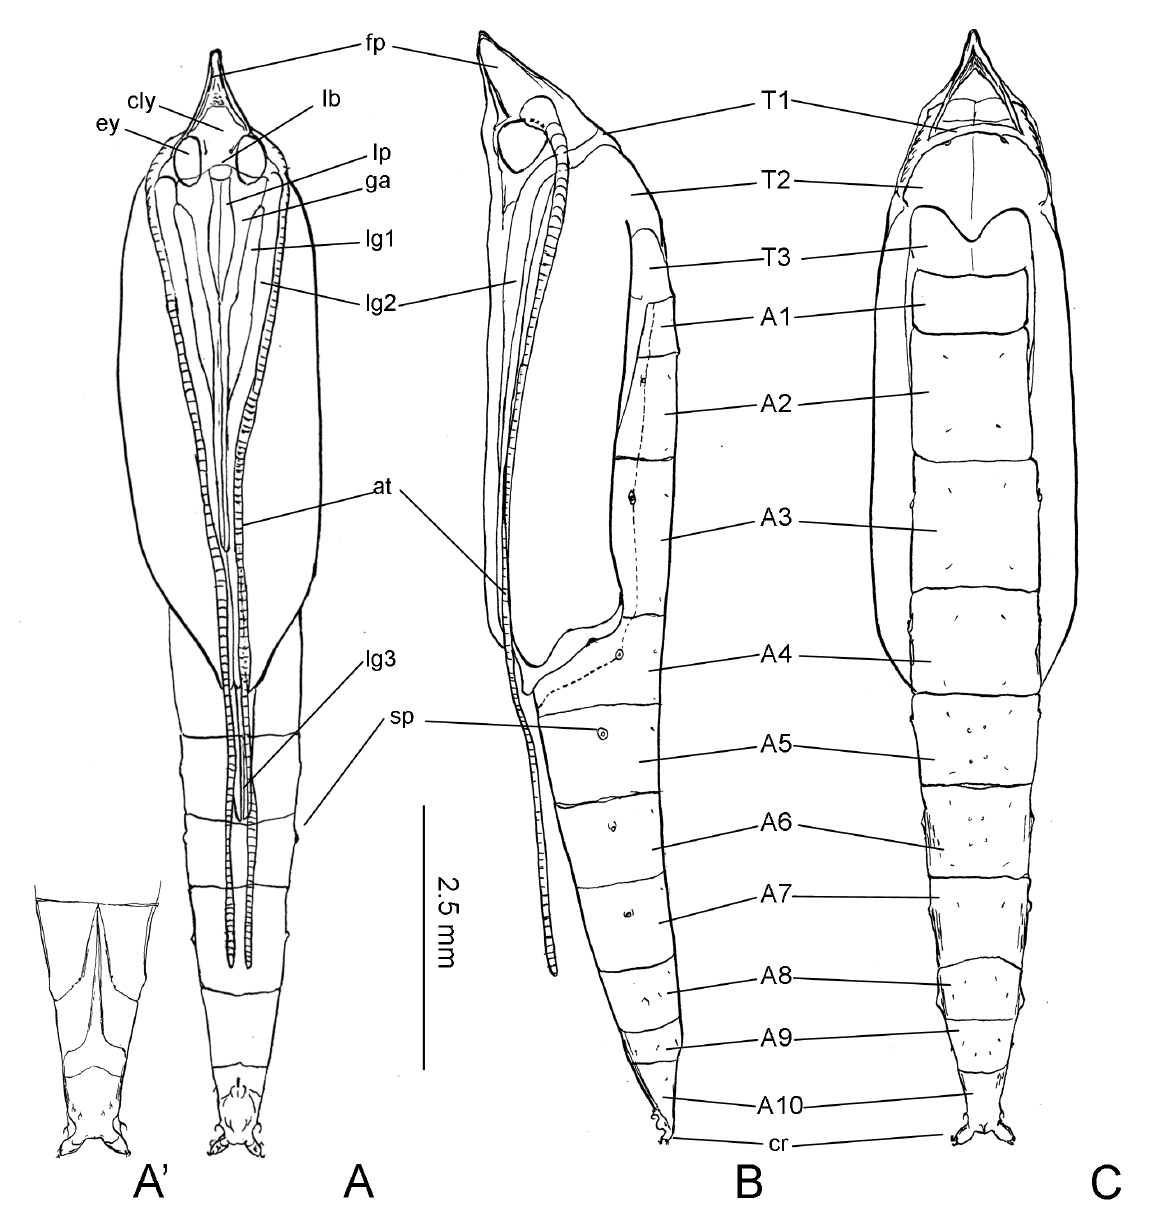
Fig. 7. Pupa of Tonza citrorrhoa Meyrick, 1905 (OPU-IN-LE2018IV0018–0024). A . Male, ventral view. A' . A7–10 of female. B . Lateral view. C . Dorsal view. Abbreviations: at = antenna; cly = clypeus; cr = cremaster; ey = eye; fp = frontal process; lb = labrum, labial palpus; lg 1 = foreleg; lg 2 = midleg; lg 3 = hindleg; pr =